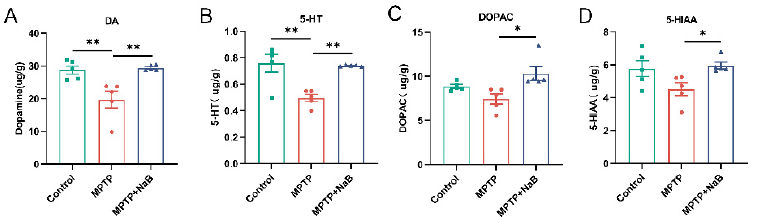
Figure 2. Sodium butyrate (NaB) increases dopamine (DA) and serotonin (5-HT) levels in the striatum of mice with 1-methyl-4-phenyl-1,2,3,6-tetrahydropyridine (MPTP)-induced Parkinson’s disease (PD). Levels of the neurotransmitters ( A ) DA, ( B ) 5-HT, and their metabolites ( C ) dihydroxyphenylacetic acid (DOPAC), and ( D ) 5-hydroxyindoleacetic acid (5-HIAA) in the striatum. n = 5 mice per group; * p < 0.05, ** p < 0.01; data are presented as means ± SEM.